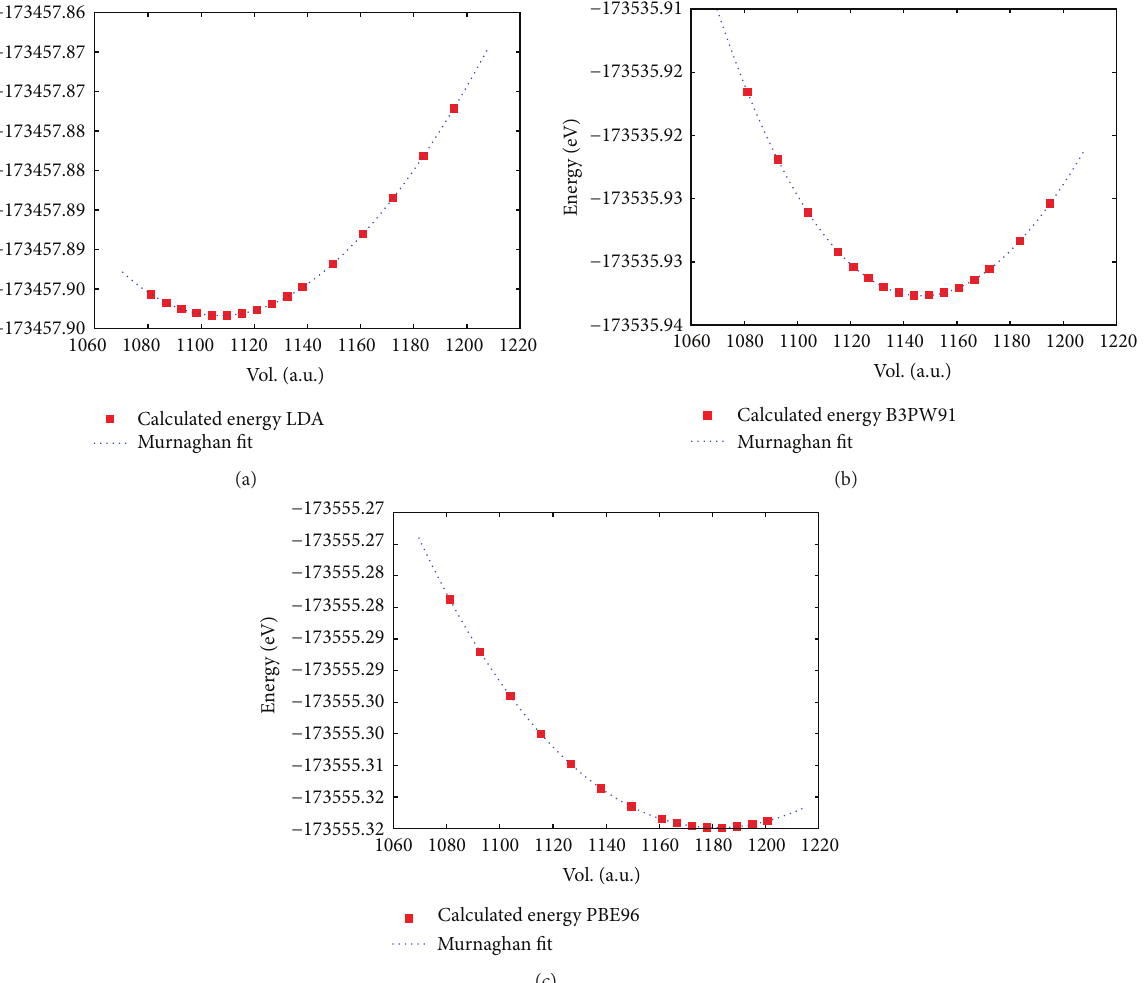
Figure 2: 𝐸 tot versus volume curve for 𝛿 -Bi 2 O 3 , obtained with the functionals (a) LDA, (b) B3PW91, and (c) PBE96. calculation of electronic properties of solid materials